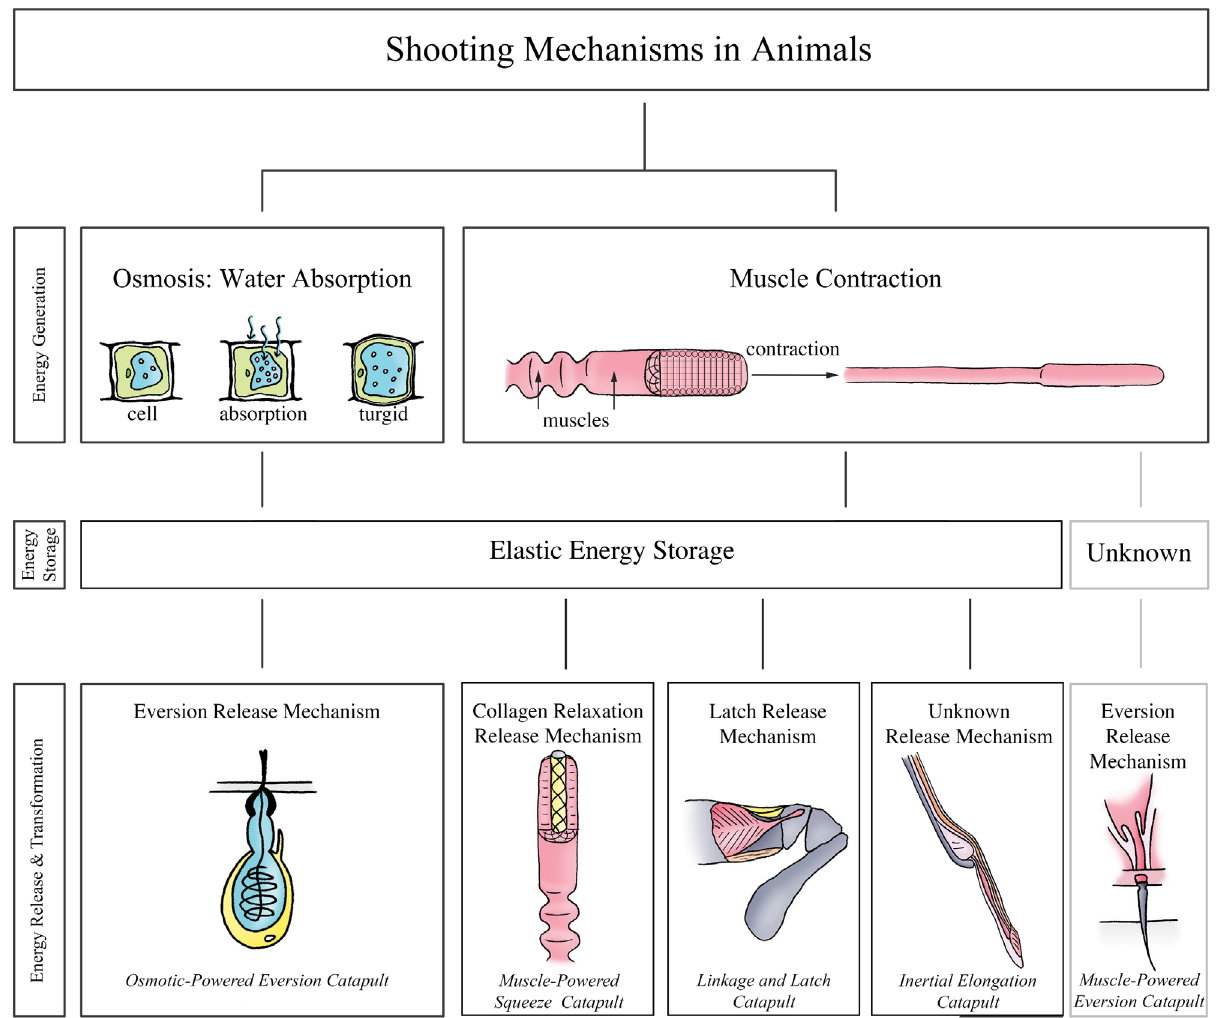
Fig 21. The structural categorization of the identified shooting mechanisms in animals, allocated based on the energy management criteria discussed above. Osmotic-powered eversion catapult : observed in the phylum Cnidaria. Muscle-powered squeeze catapult : observed in the family Chamaeleonidae, schematic illustration of Chameleo calyptratus . Linkage and latch catapult : observed in the order Stomatopoda, schematic illustration of Odontodactylus scyllarus . Inertial elongation catapult : observed in the families Bufonidae, Microhylidae, Dendrobatidae, Megophryidae, Leptodactylidae, and Ranidae within the order Anura, schematic illustration of Bufo marinus . Muscle-powered eversion catapult : observed in the families Ariophantidae, Bradybaenidae, Dyakiidae, Helicidae, Helminthoglyptidae, Hygromiidae, Parmacellidae, Urocyclidae, and Vitrinidae, within the clade